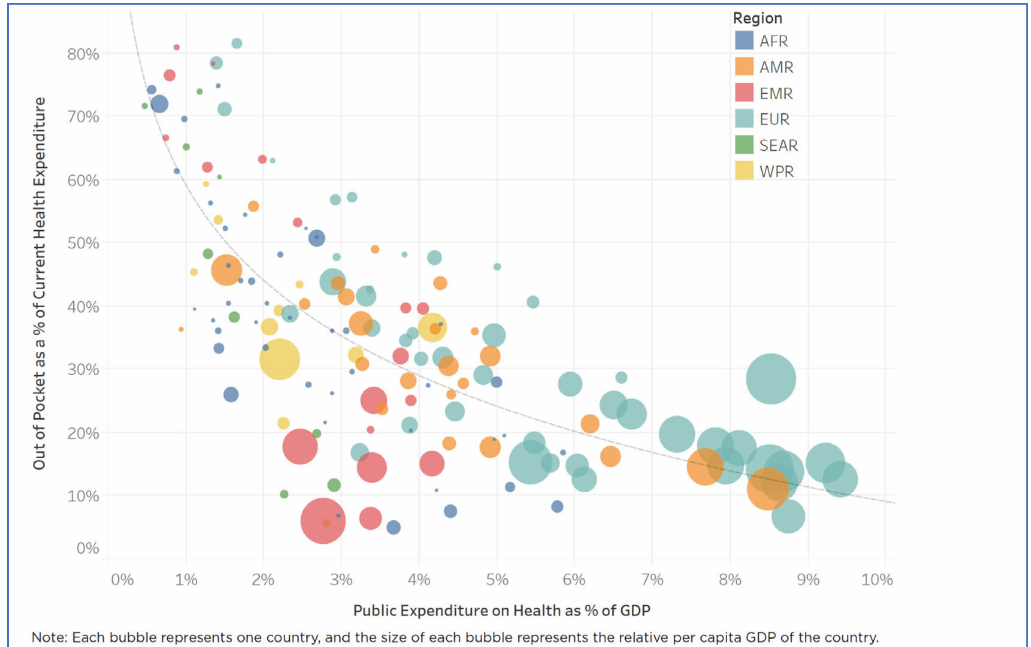
Figure 7. Negative correlation between public health spending as % GDP and the proportion of out-of-pocket payment as % total health expenditure. Data source: New Perspective on Global Health Spending for Universal Health Coverage, Global report: Conference copy for consultation, WHO, 2018